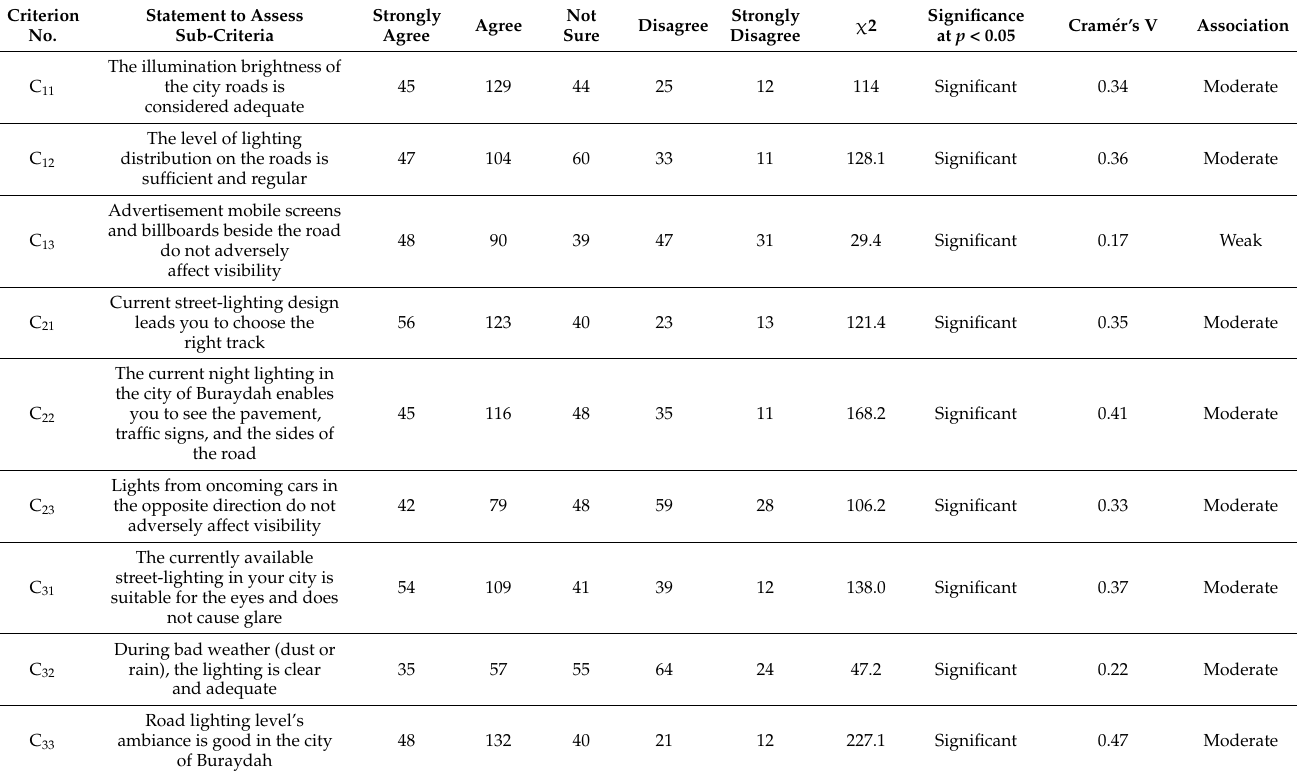
Table 3. Summary of responses, hypotheses, and the level of association between sub-criteria provided in Table 1 and overall